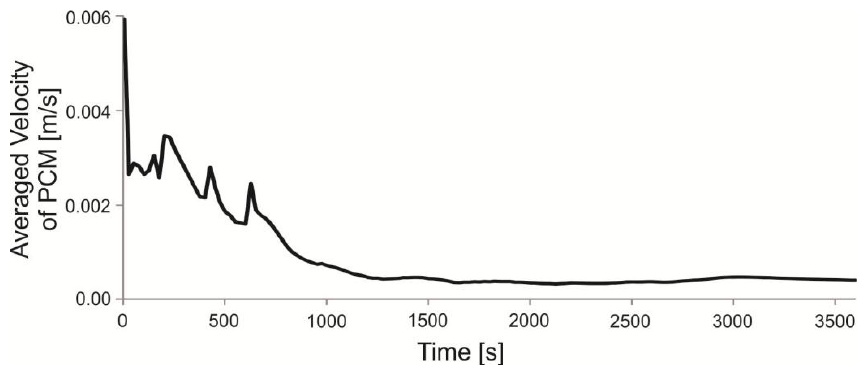
Figure 8. Chronological sequence of the volume averaged velocity during the charging process. Such velocity peaks cannot be observed after approximately 800 s after simulation start.